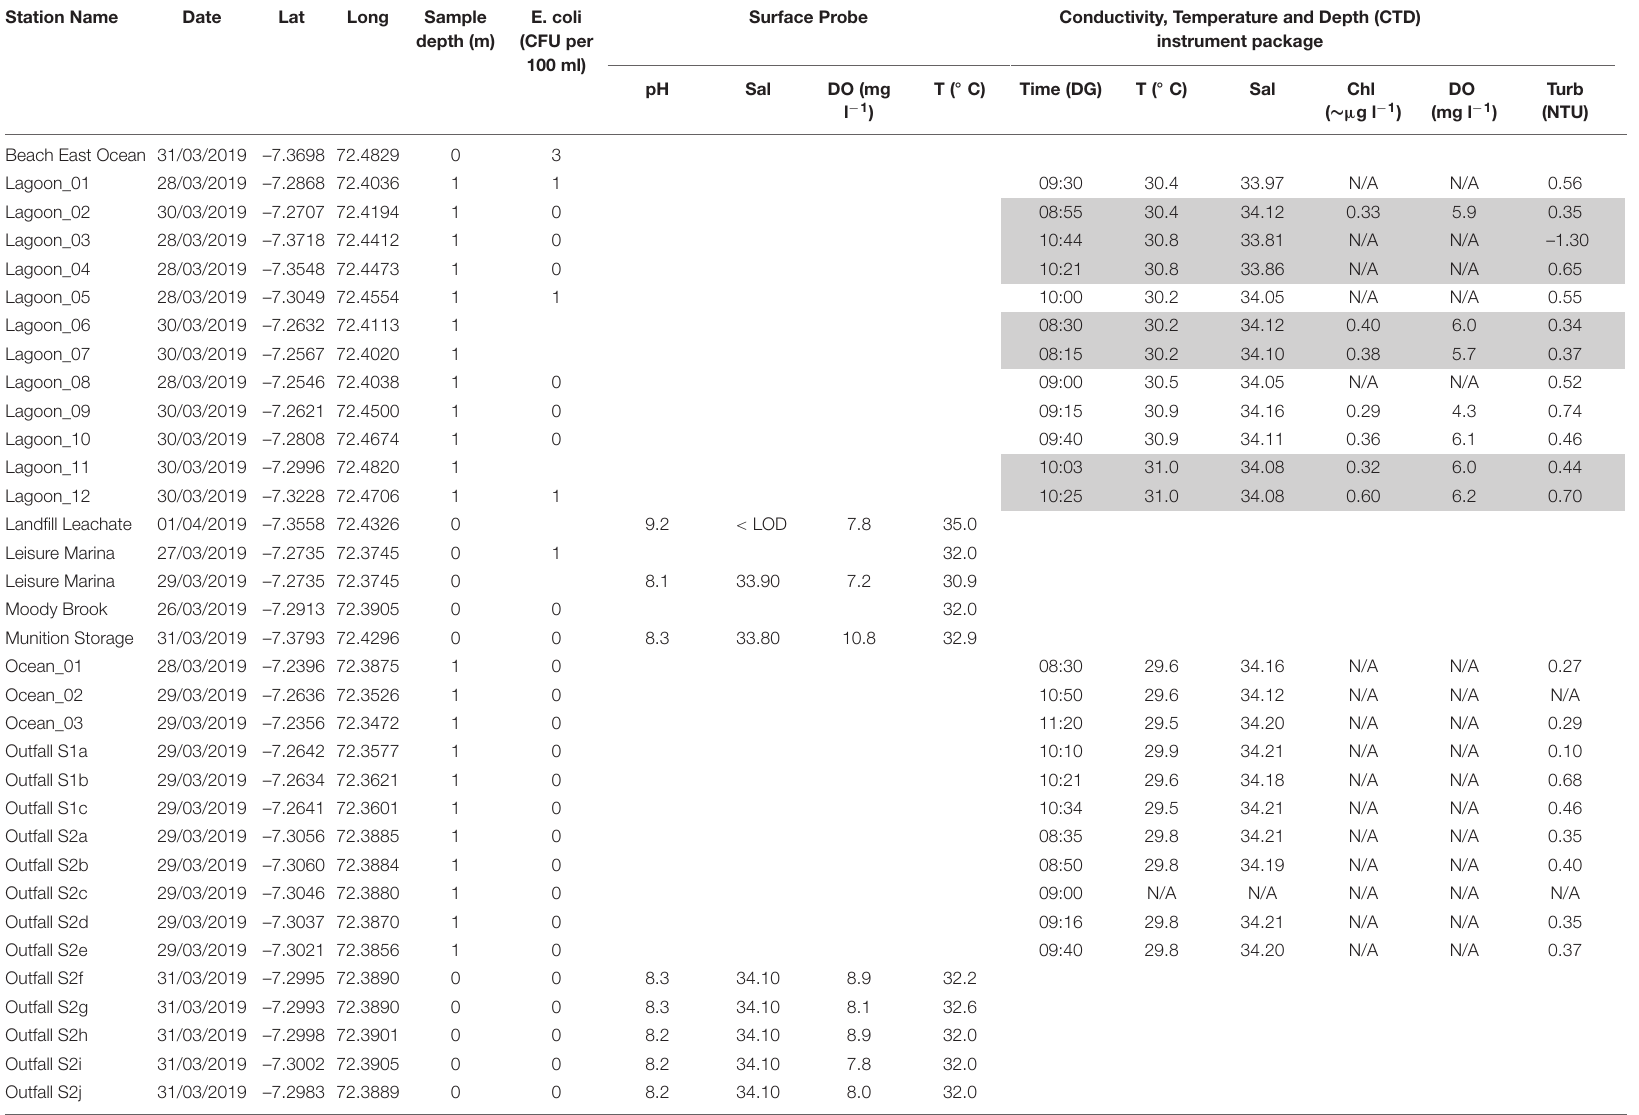
TABLE 2 | Surface measurements from sensors (surface probe and CTD) and counts for fecal indicator bacteria (colony forming units, CFU, per 100